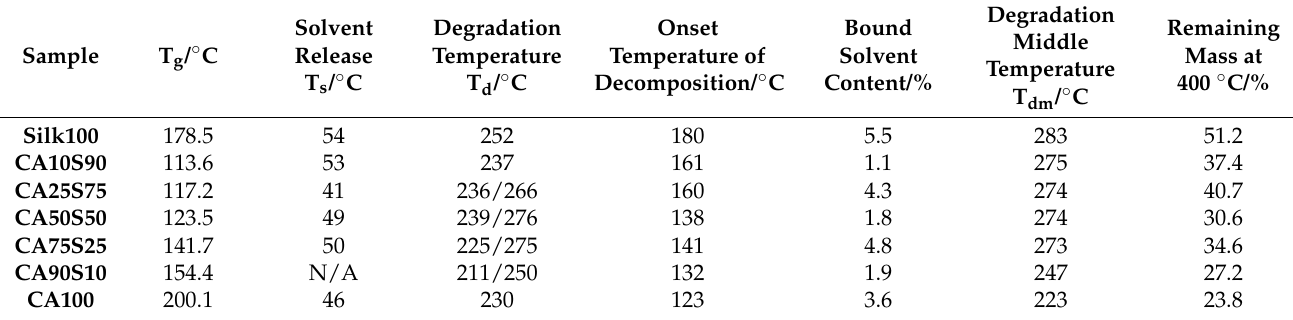
degradation peak temperature of different silk-CA films,